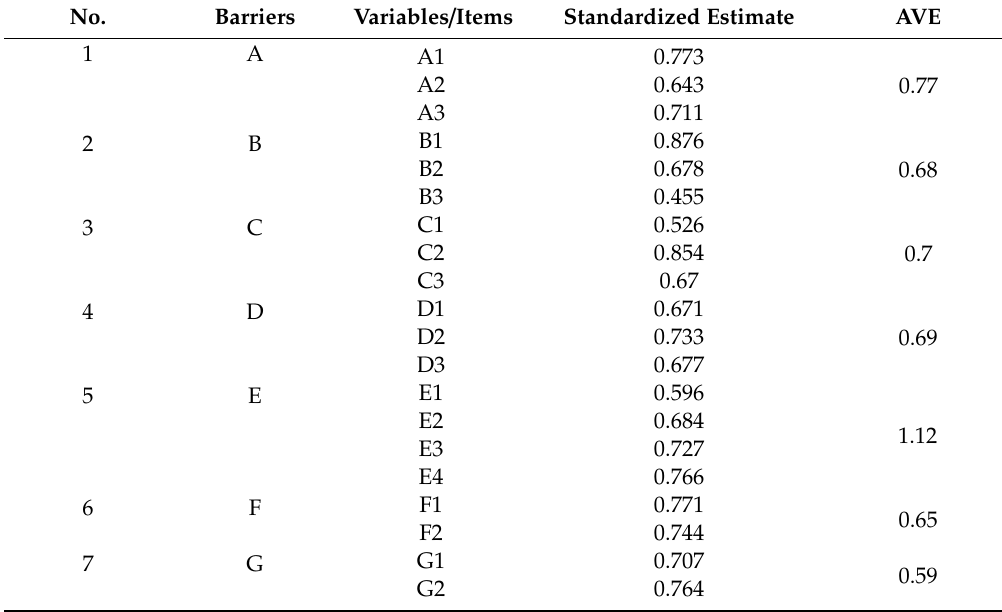
Table 3. Results of confirmatory factor